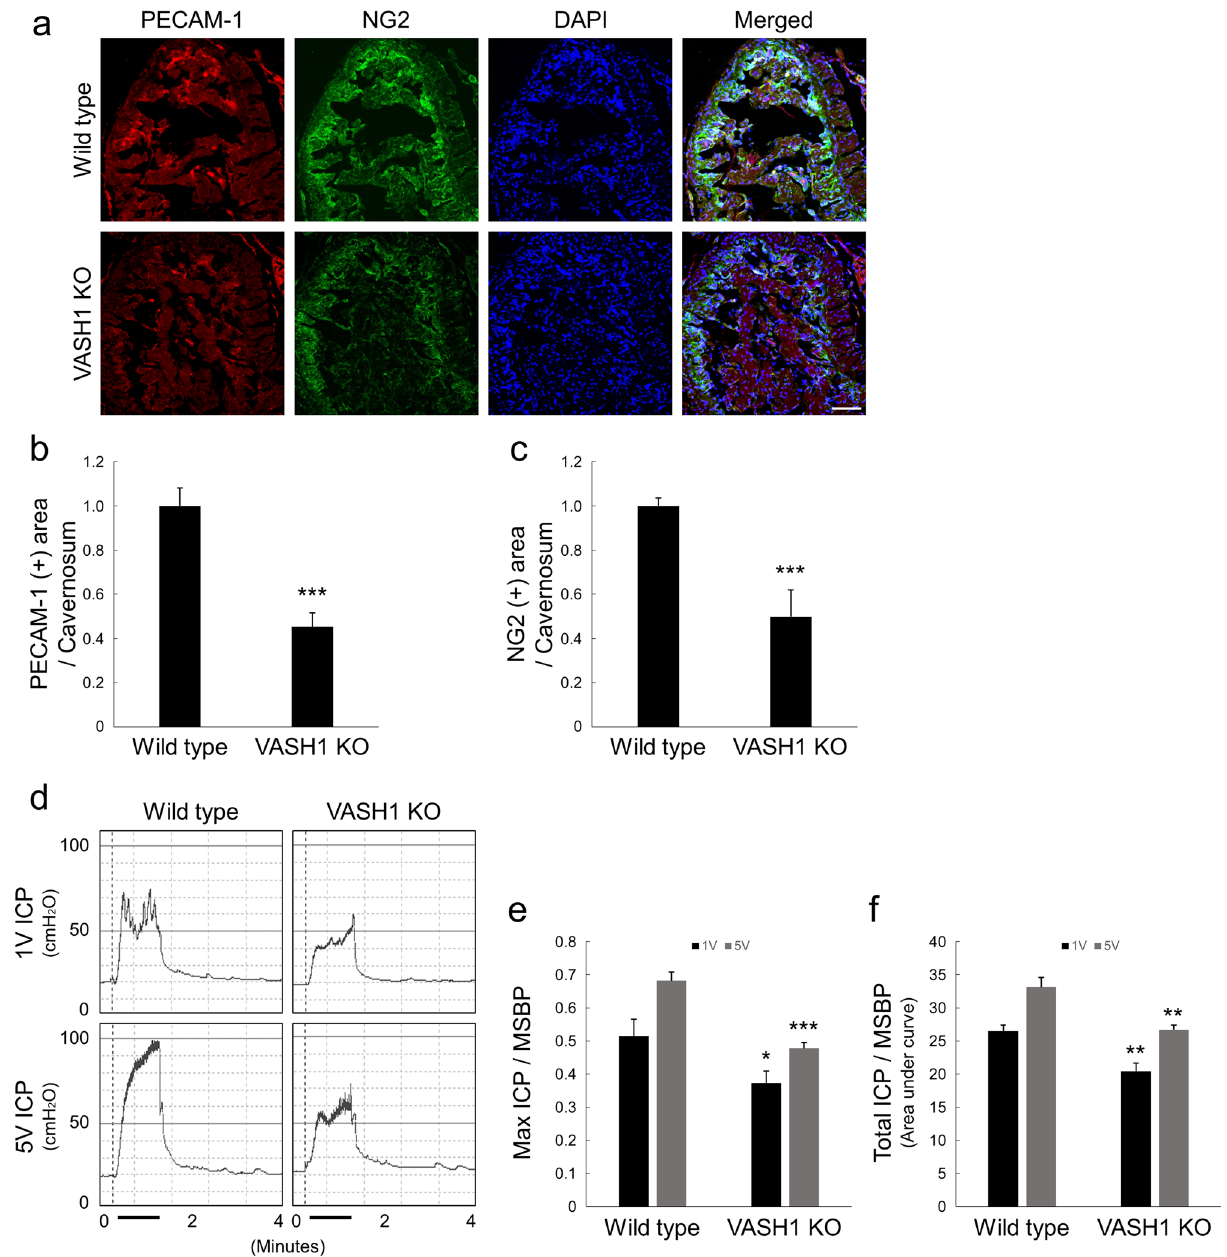
Figure 2. The decrease in cavernous endothelial cell-pericyte contents and impairment of erectile function in VASH1-knockout mice. ( a ) PECAM-1 (red) and NG2 (green) staining in corpus cavernosum of wild-type and VASH1 -/- mice. Scale bar = 100 µm. ( b , c ) Quantification of cavernous endothelial cell and pericyte content by Image J. Each bar depicts the mean (± SE) values from N = 6 animals per group. *** P < 0.001 vs. wild-type mice. ( d ) Representative intracavernous (ICP) responses for the wild-type and VASH1 −/− mice. The stimulus interval is indicated by a solid bar. ( e , f ) Ratios of mean maximal ICP and total ICP (area under the curve) to mean systolic blood pressure (MSBP) calculated for each group. Each bar depicts the mean (± SE) values from N = 6 animals per group. * P < 0.05, ** P < 0.01, *** P < 0.001 vs. wild-type